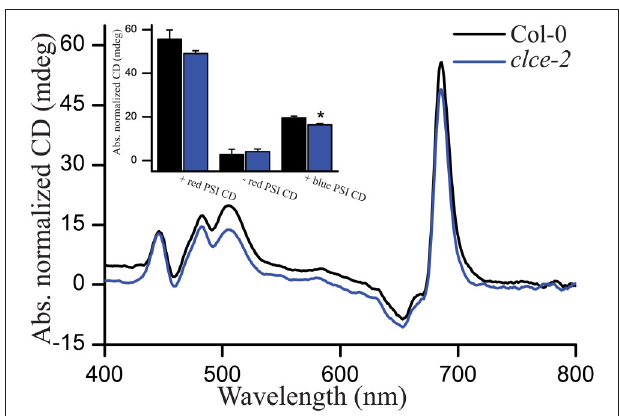
FIGURE 9 | Representative circular dichroism (CD) spectra of H 2 O-infiltrated detached leaves. Insets are amplitudes of psi-type CD bands at around ( + )505nm ( + blue), ( − )675nm ( − red). and ( + )690nm ( + red), with reference wavelengths at 550, 600. and 750nm, respectively. Data are the means ± SEM ( n = 3 plants). Asterisks indicate significant differences (ANOVA, P < 0.05